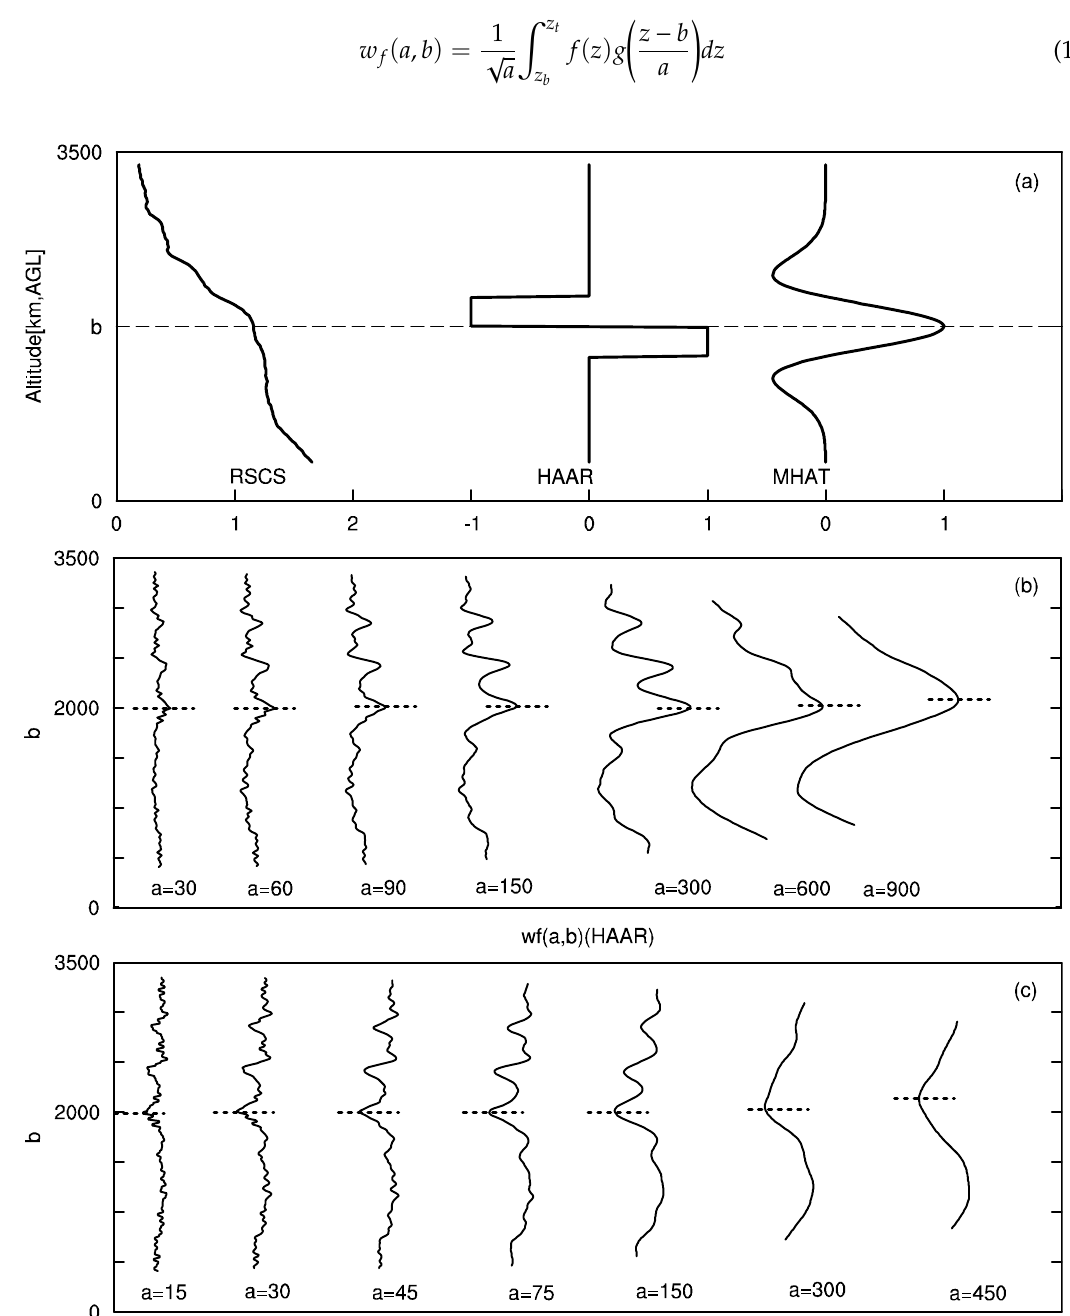
Figure 5. ( a ) RSCS profile with the shapes of HAAR wavelet (HAAR) and the Mexican-Hat wavelet (MHAT), the resulting covariance transform for ( b ) HAAR and ( c ) MHAT at various values of the dilation at 06:00 UTC on 10 September 2010 over SACOL.